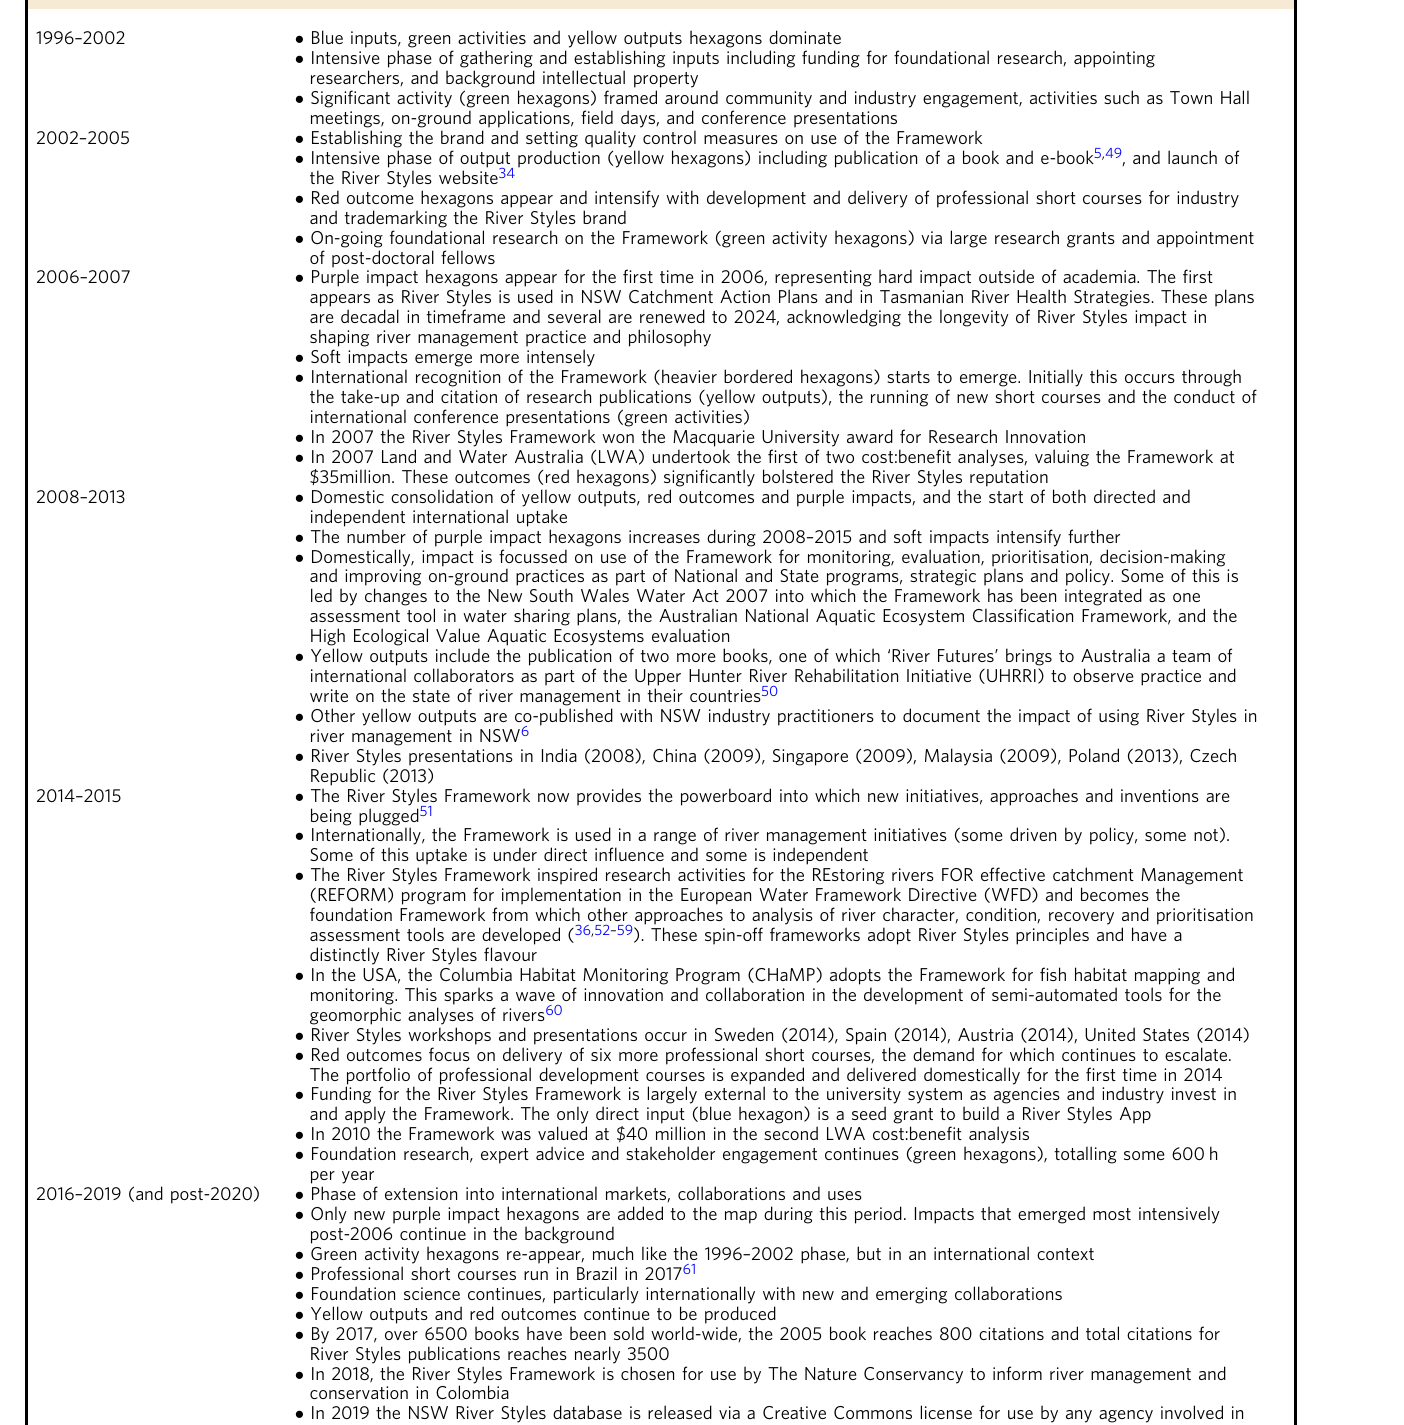
Table 1 The River Styles Framework impact story (pre-1996 to post-2020) 1996 – 2002 (cid:129) Blue inputs, green activities and yellow outputs hexagons dominate (cid:129) Intensive phase of gathering and establishing inputs including funding for foundational research,